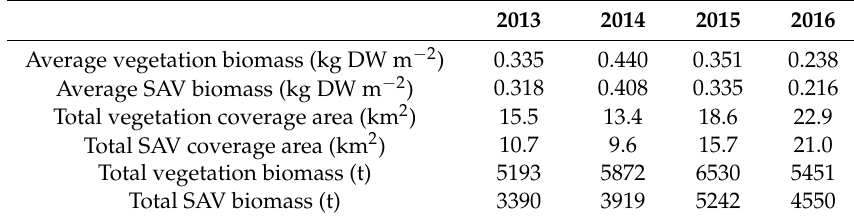
Table 8. Estimated SAV biomass in the south basin of Lake Biwa using the Spectral Decomposition Algorithm for October 2013, and September 2014, 2015,